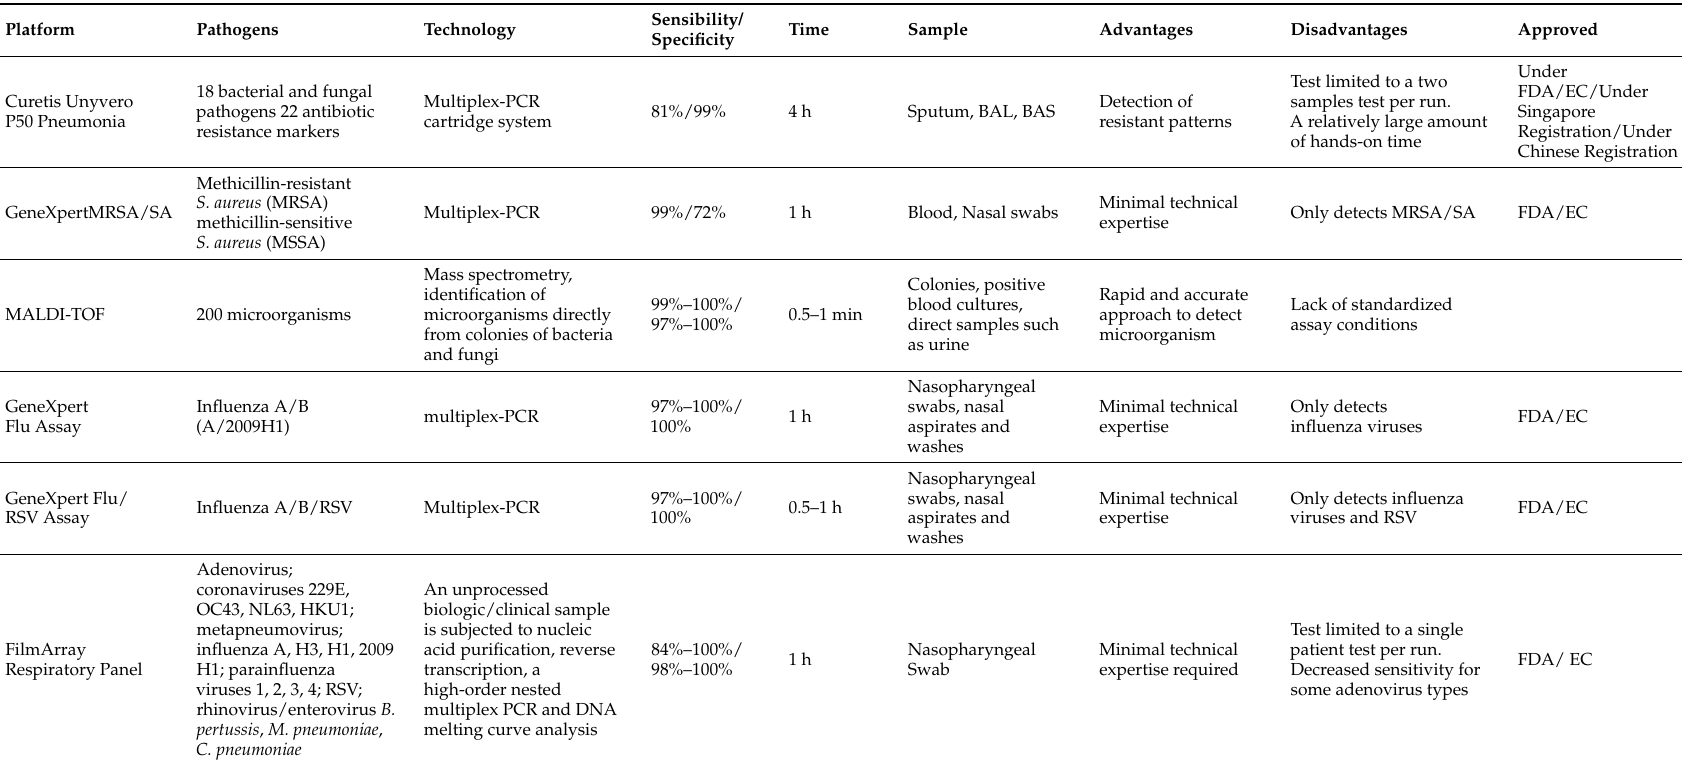
Table 2. Molecular platforms for pneumonia